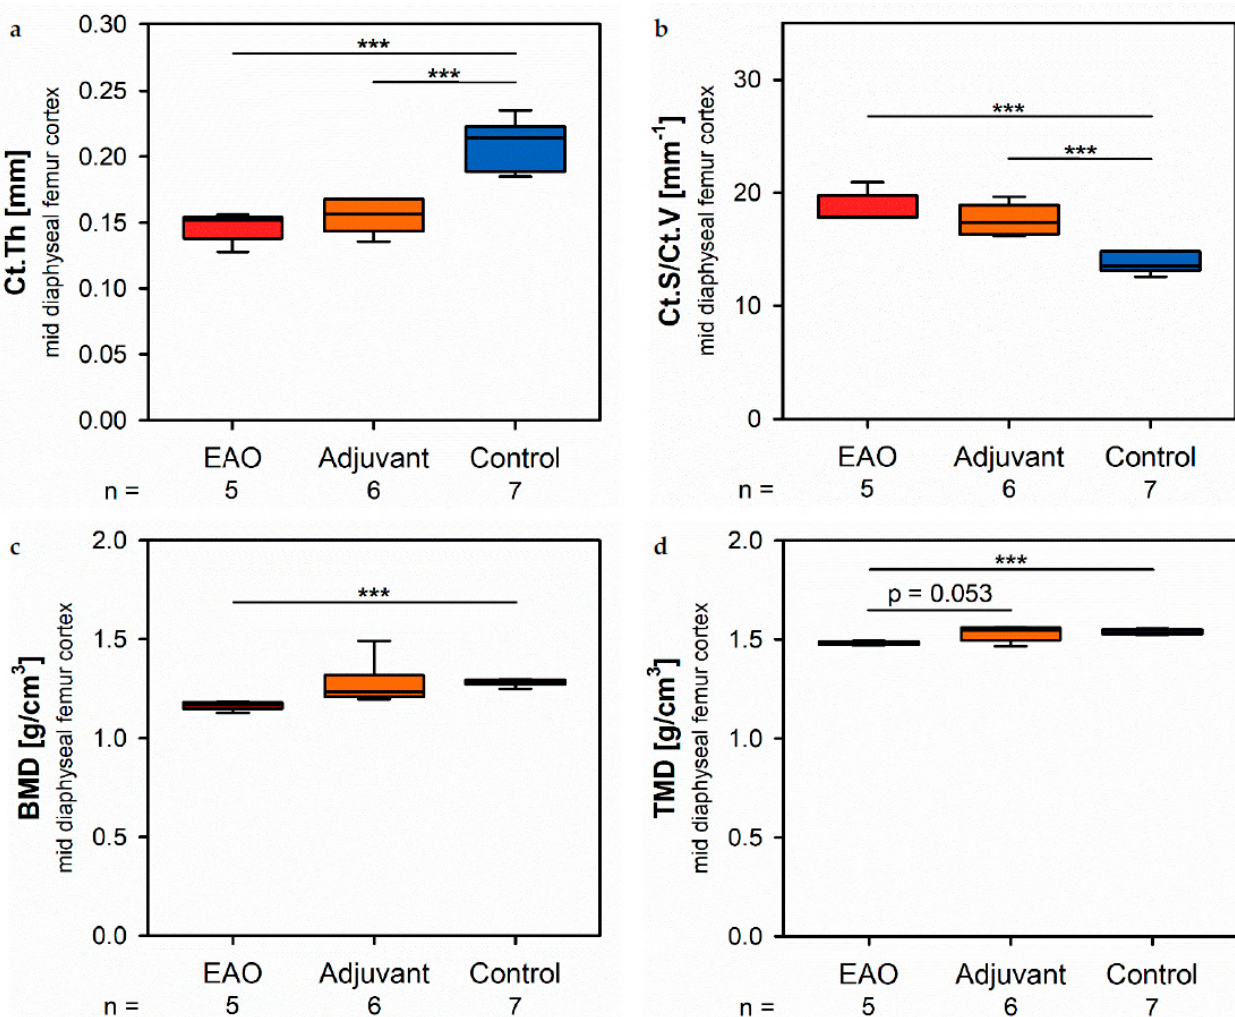
Figure 4. Microarchitecture of mid diaphyseal femur cortex in µCT. Measurement of ( a ) cortical thickness (Ct.Th), ( b ) cortical surface/volume ratio (Ct.S/Ct.V), ( c ) bone mineral density (BMD) and ( d ) tissue mineral density (TMD). Mice were immunized with testicular homogenate in adjuvant (EAO), adjuvant alone (adjuvant) or remained untreated (control). *** p < 0.001.